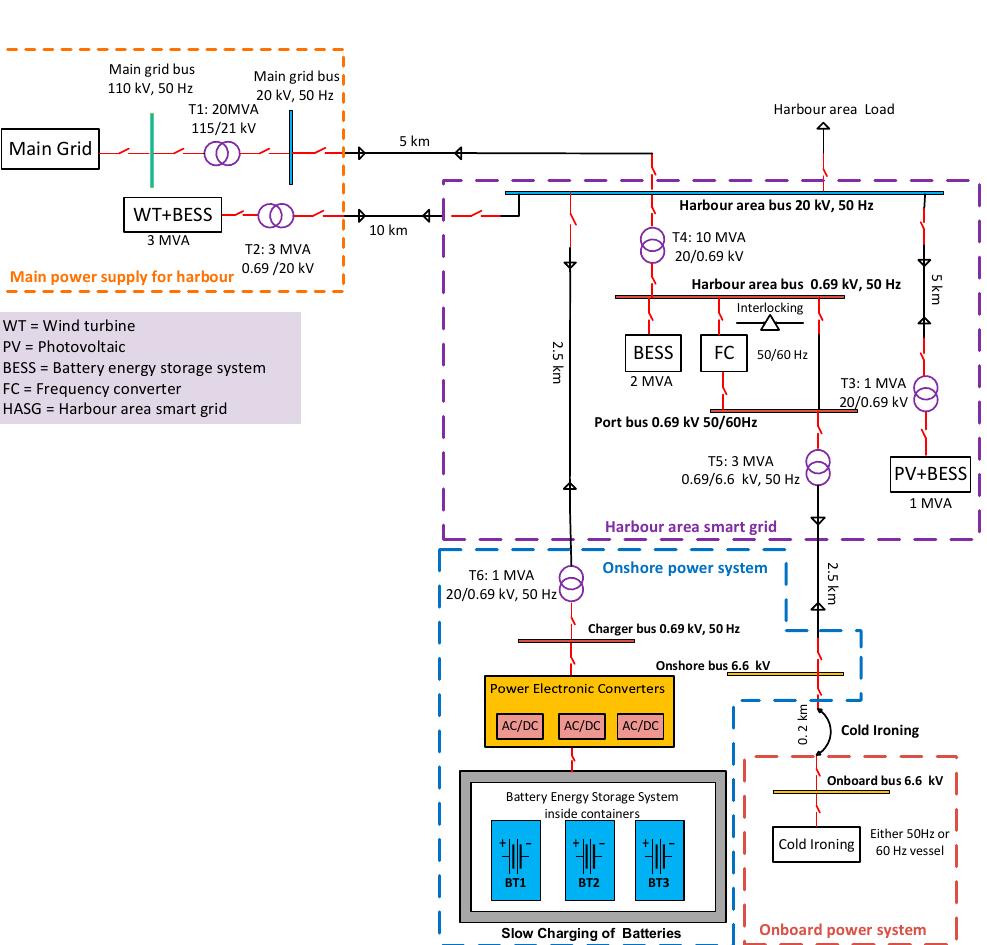
Figure 2. Configuration A: Container-based charging of batteries and cold-ironing.